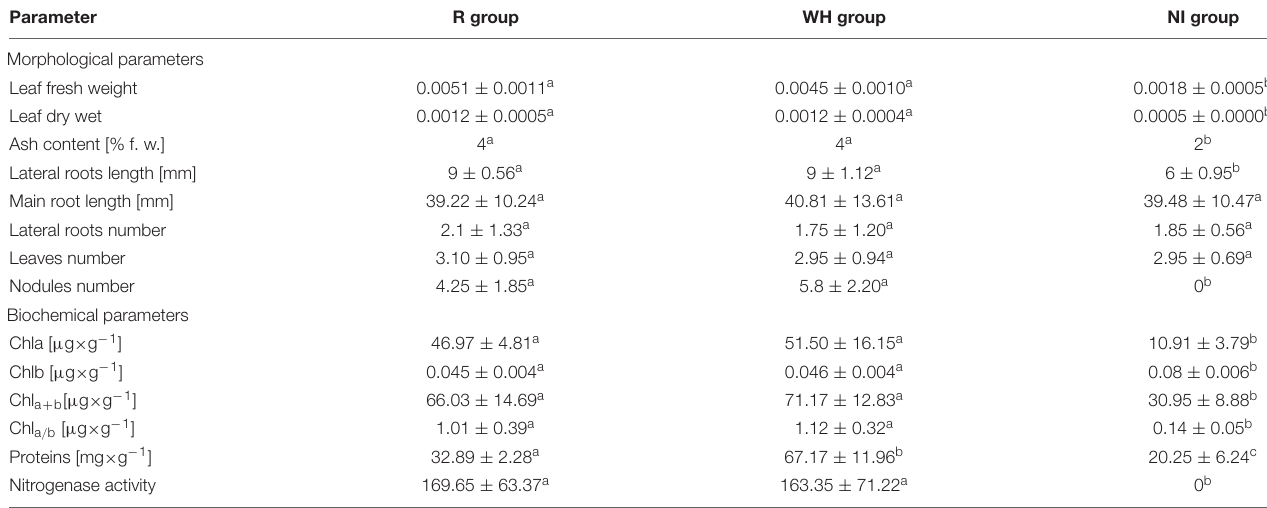
TABLE 1 | Morphological and biochemical parameters of growth of T. repens inoculated with R. leguminosarum bv. trifolii from the reference area (R group), the metal-polluted waste heap (WH group), and non-inoculated with rhizobia strains (NI group). Parameter R group WH group NI group Morphological parameters